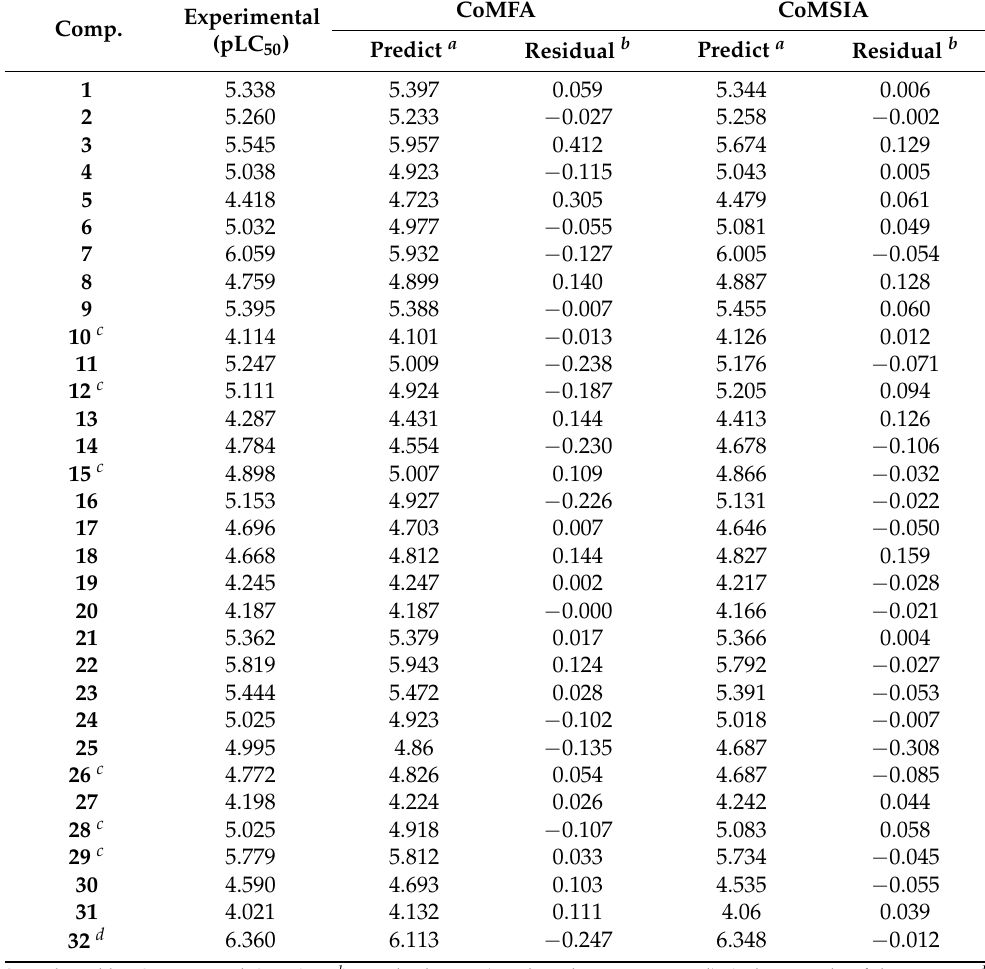
Table 3. Experimental and predicted results of pLC 50 for the CoMFA and CoMSIA